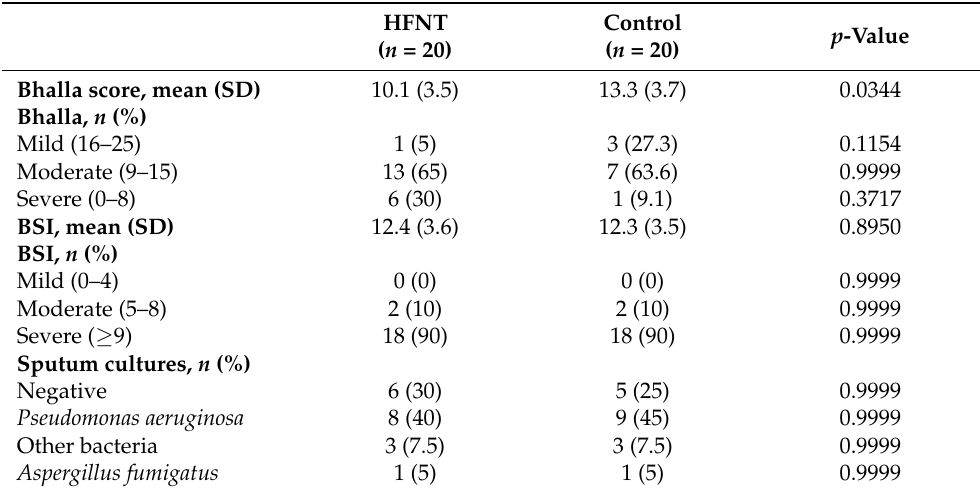
Table 2. Bronchiectasis severity assessment and microbial sputum